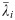
Convergence of the Sloppy Algorithm.Convergence of λ¯i (A) and s
i (B) when the Sloppy Algorithm was used with different initial values of s; s
0 = 10−5, light green, square; magic number, red, circle; 0.5, green, up-triangle; 0.7, blue, diamond; 1.0, magenta, down-triangle. Dashed black line marks the correct values of L = 0.723 and s* = 0.377.